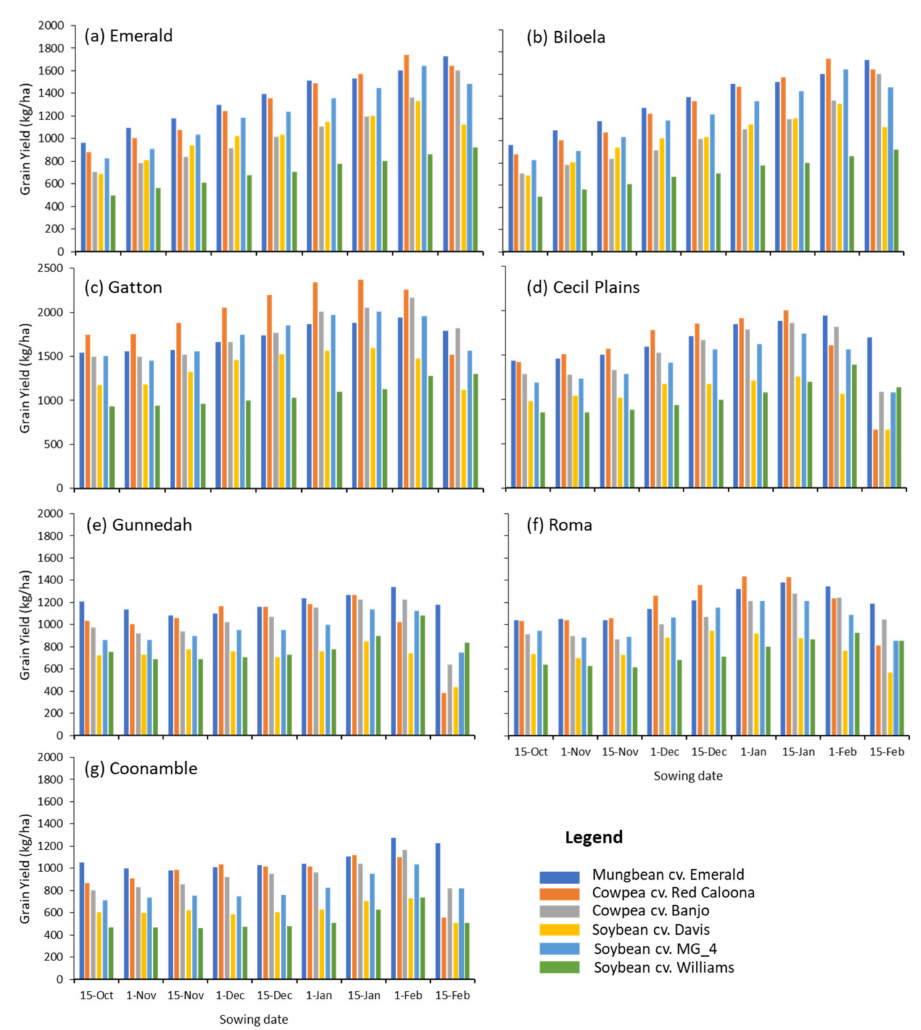
Figure 2. APSIM-predicted long-term average (1979–2018) grain yield (kg/ha) for different tropical grain legume genotypes sown at different times at 7 locations spanning the subtropical grain- producing environments of Australia. See Table 1 for details of climate and soils at each